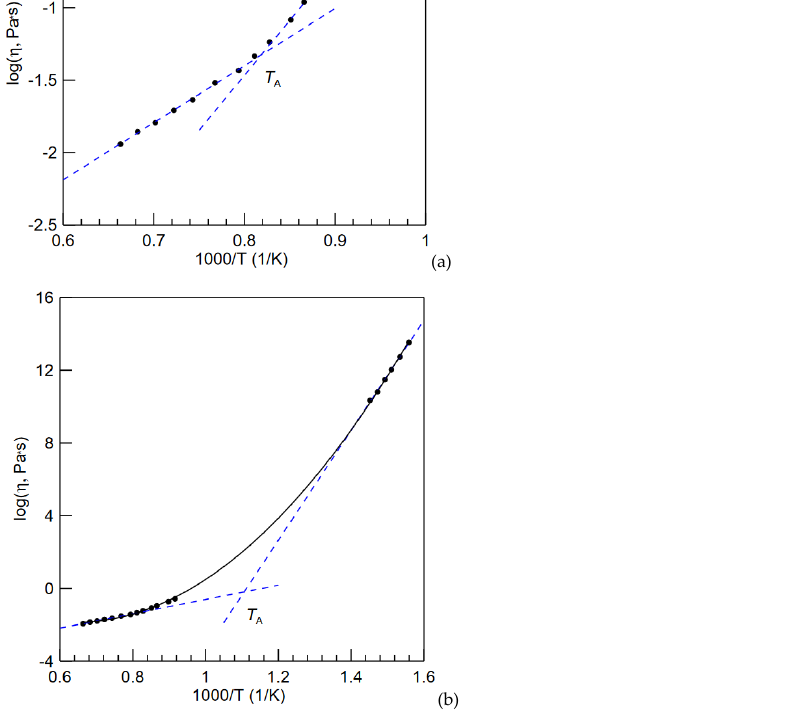
Figure 4. Log( η ) of the Zr 58.5 Cu 15.6 Ni 12.8 Al 10.3 Nb 2.8 (Vit106a) alloy as a function of 1000/T in two ranges ( a , b ). The data points are obtained from Ref. [76]. ranges ( a , b ). The data points are obtained from Ref.